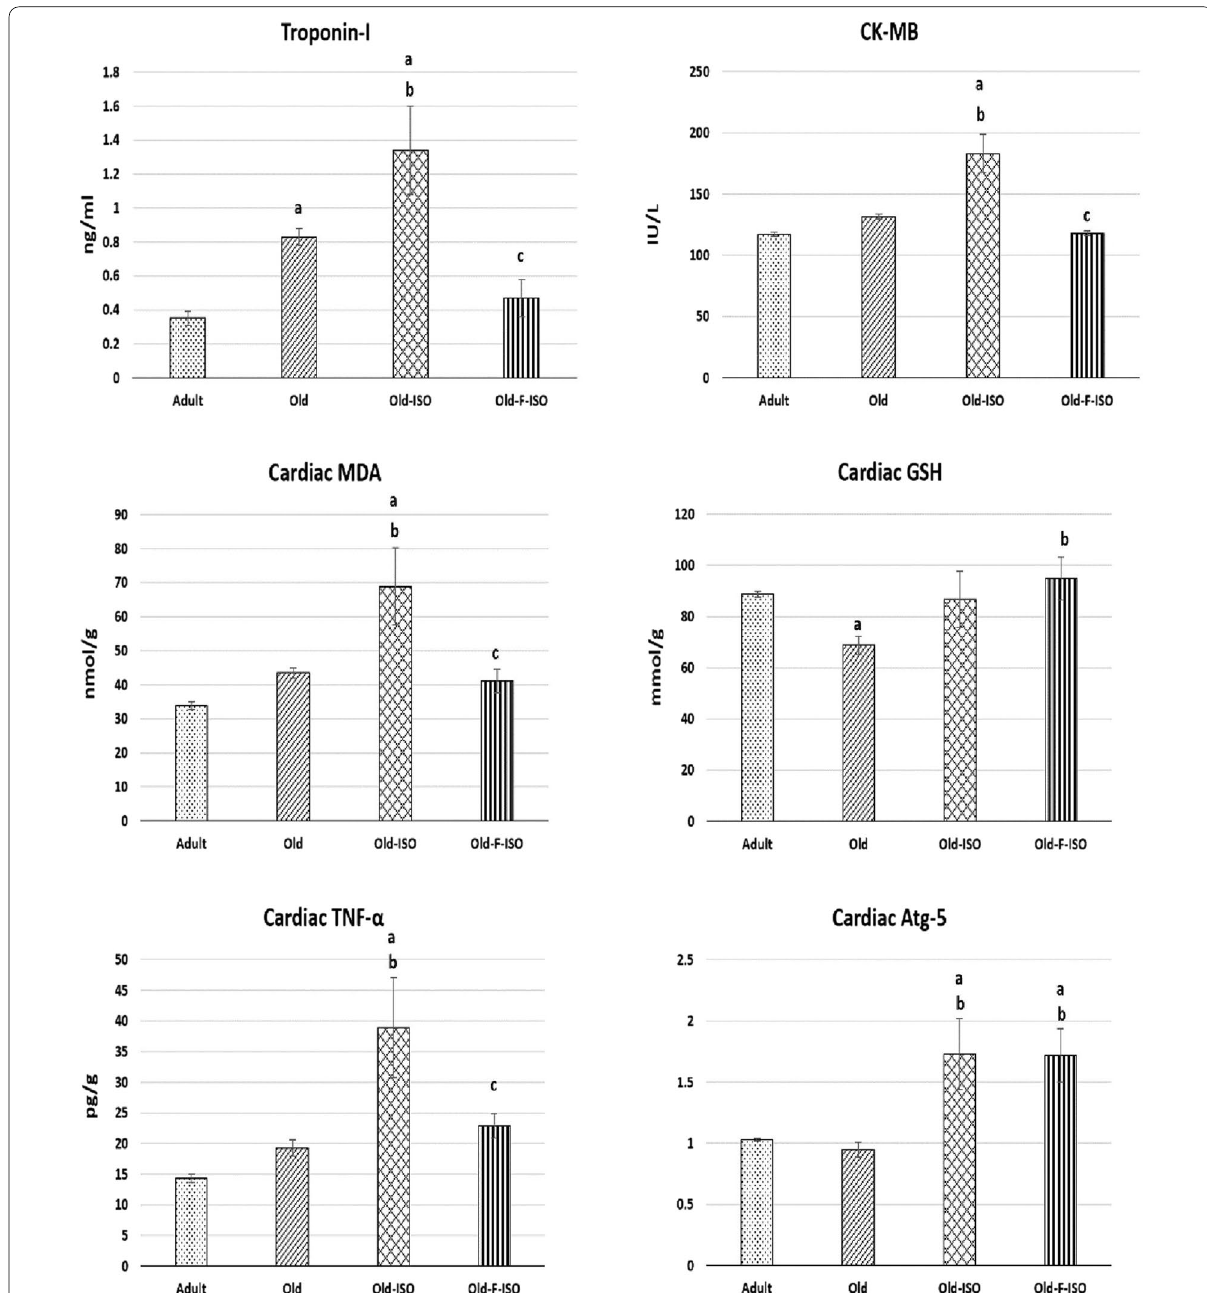
Fig. 1 Changes in plasma level of Troponin‑I, Creatine Kinase‑MB (CK‑MB), cardiac level of malondialdehyde (MDA), reduced glutathione reduced (GSH), tumor necrosis factor‑alpha (TNF‑α), and mRNA expression of cardiac autophagy related protein‑5 (Atg‑5) in the four study groups. Data are expressed as mean SEM. Number in parenthesis is the number of rats in each group. a Significance of difference from adult group by LSD test at ± P < 0.05. b Significance of difference from old group by LSD test at P < 0.05. c Significance of difference from Old‑ISO group by LSD test at P <